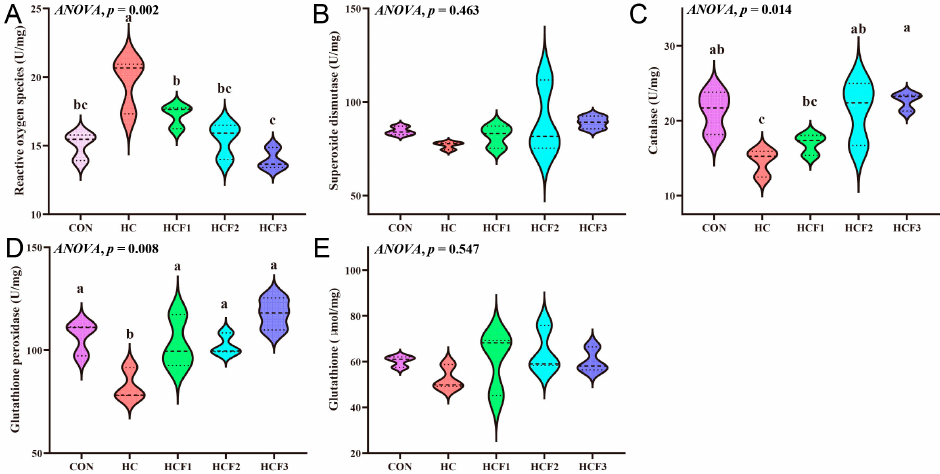
Figure 3. Influences of dietary mulberry leaf flavonoids on antioxidant enzymes activities in the liver of rice field eel fed on a high-carbohydrate diet. ( A ) Reactive oxygen species, ROS; ( B ) Superoxide dismutase, SOD; ( C ) catalase, CAT; ( D ) Glutathione peroxidase, GPx; ( E ) Glutathione, GSH. Different letters show a significant difference ( p < 0.05).